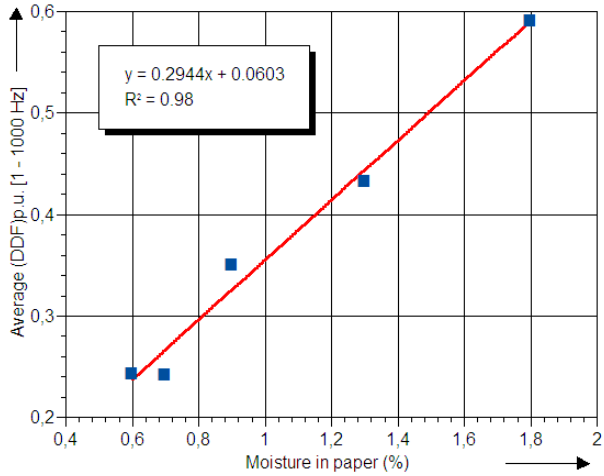
Figure 14. Correlation between the average value of the DDF in the frequency range [1–1000] Hz and moisture content in the